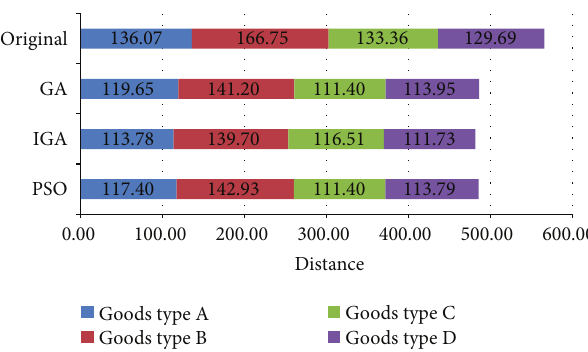
Figure 14: The Gantt chart for different travelled distances under Case 2.